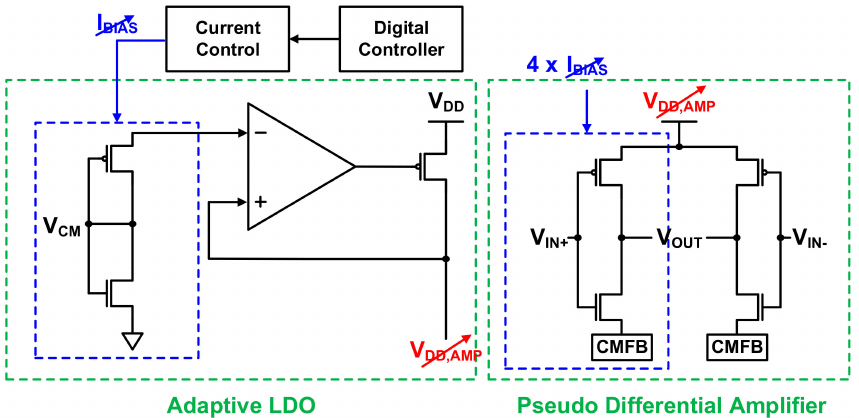
Figure 19. Main amplifier structure consisting of adaptive LDO and pseudo-differential